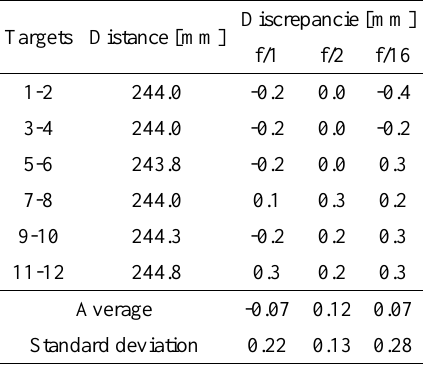
Figure 6. Calibration Scene: Detection of targets gradually worsens and requires more operator